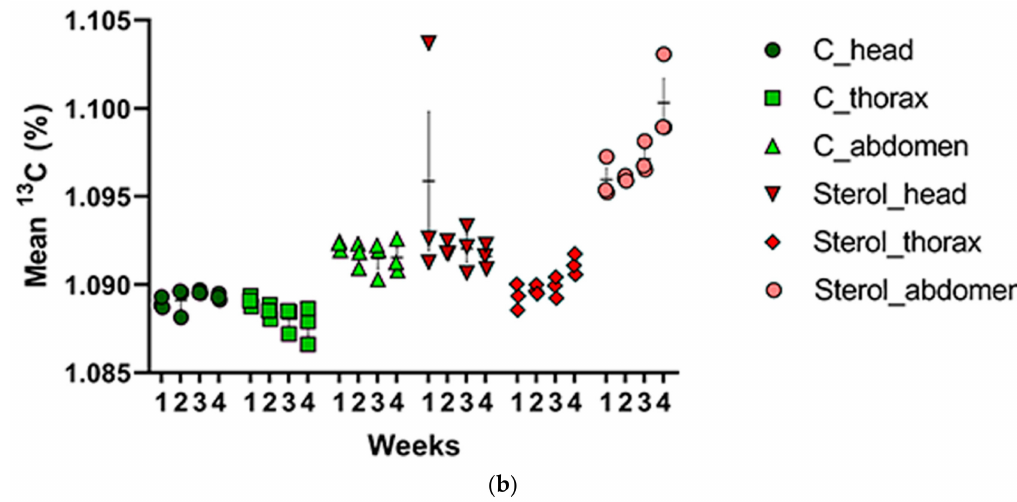
Figure 5. ( a ) Mean total carbon ( µ g) and ( b ) mean percentage of 13 C for the control and treatment groups in all tissues across four weeks. C: honey bees fed diet with no sterol; Sterol: honey bees fed diet containing 0.25% 13 C-labeled 24-methylenecholesterol. Bars indicate ±